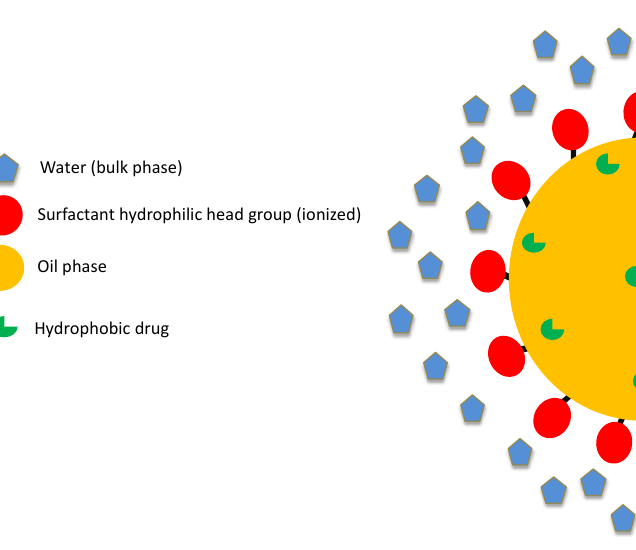
Figure 1. Structure of drug loaded emulsion system.